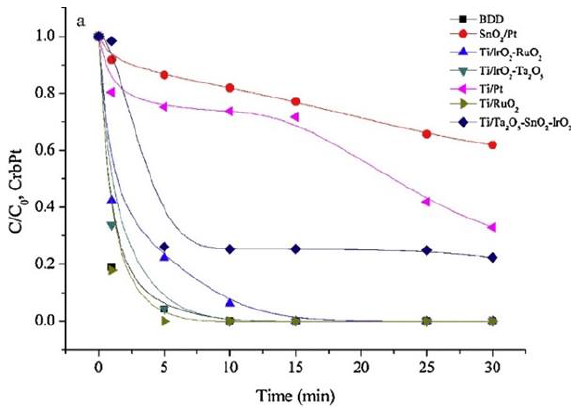
Figure 4. The effect of electrode material on anti-cancer drug carboplatin degradation under conditions: supporting electrolyte, 200 mg/L Na 2 SO 4 ; pH 7; current density, 30 mA cm −2 . Reprinted from Barı¸sçı et al. [59], copyright © (2018), with permission from